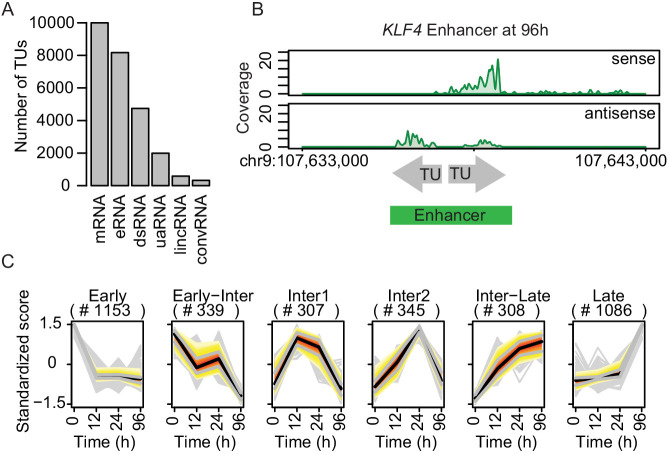
TT-seq identifies transcriptionally active enhancers.(A) TT-seq identified various classes of RNAs including previously annotated stable messenger RNAs (mRNAs), novel transient enhancer RNAs (eRNAs), and other noncoding RNAs (downstream RNAs (dsRNAs), upstream antisense RNAs (uaRNAs), long intergenic noncoding RNAs (lincRNAs), convergent RNAs (convRNAs)). (B) TT-seq coverage tracks on KLF4 enhancer at 96 hr exemplify how RNAs that were synthesized within 1 kb of another were merged into a single enhancer. (C) Dynamically regulated eRNAs (|log2(FC)|>1, FDR < 0.05) were clustered using k-means clustering according to the kinetics of synthesis level changes during transdifferentiation. Black line represents median. Red, yellow, and gray represent 0.25, 0.5, and 0.75 quantiles, respectively.